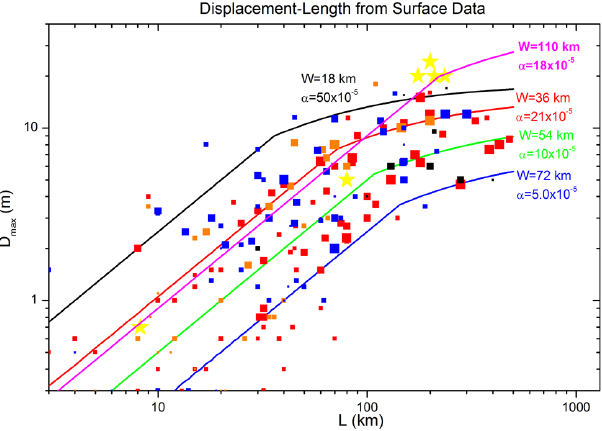
Fig. 4. Maximum displacement versus fault length derived from surface measurements (adapted from Manighetti et al., 2007): red squares, strike-slip events; orange squares, dip-slip events; blue squares, composite faults. The black squares were not used in the regression analysis. The size of the symbols is proportional to the quality of data. Also represented are the four typical laws selected by the automatic regression of Manighetti et al. (2007; coloured lines). The data points from the Gulf of Cadiz are plotted as yellow stars, and the magenta line depicts the adopted scaling law (see text for